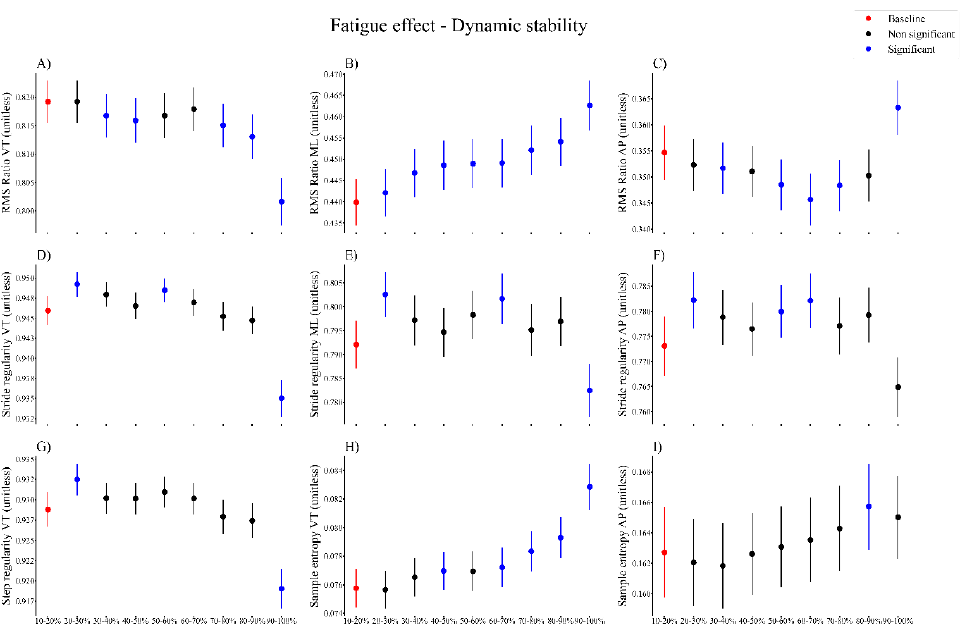
Figure 3. Time series of the overall significant fatigue effects (represented by blue dots) for dynamic stability measures (( A – C ) RMS Ratio in vertical, mediolateral and anteroposterior direction; ( D – F ) Stride regularity in all 3 directions; ( G ) step regularity in the vertical direction; ( H – I ) Sample entropy in the vertical and anteroposterior direction) for all participants, compared to baseline (represented by red dots). VT, vertical, ML, mediolateral, AP, anteroposterior.